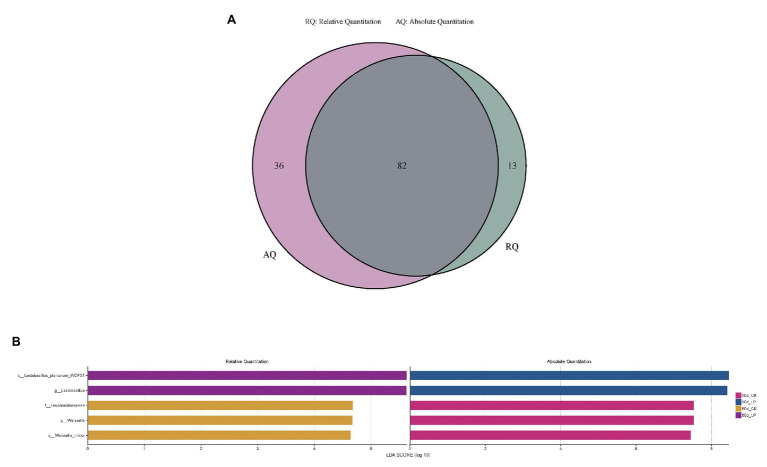
Comparison of microbial variations using LefSe analysis illustrated by RQS and AQS in Venn (A) and barplot (B) form. CK, control; LP, inoculated with L. plantarum A345. The numbers ahead of CK and LP stand for ensiled days of silage.